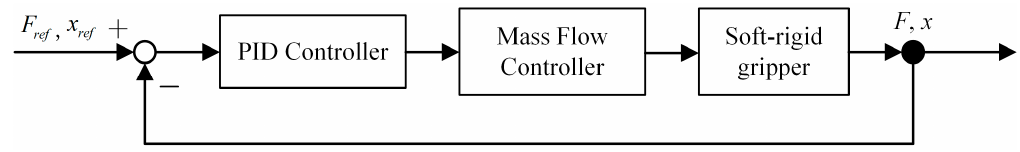
Figure 6. Block diagram of the control method in control and measurement system of the gripper.